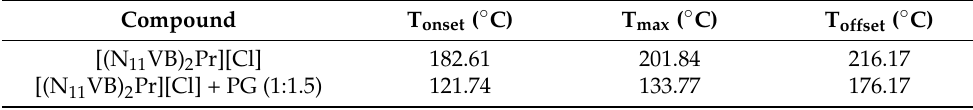
Table 2. Temperatures of polymerization for studied ionic